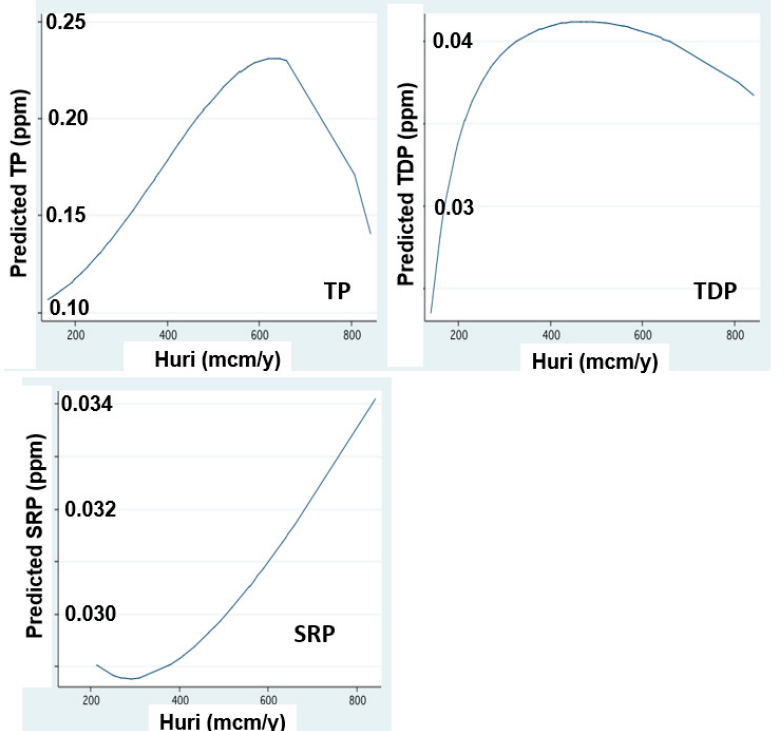
Figure 4. The increase of P form concentrations In relation to discharge: FP regression between annual (1970–2018) mean 4: concentrations (ppm) of Total Phosphorus (TP), Total Dissolved Phosphorus (TDP) and Soluble Reactive Phosphorus (SRP) in Jordan waters and annualJordan discharge (mcm/y).